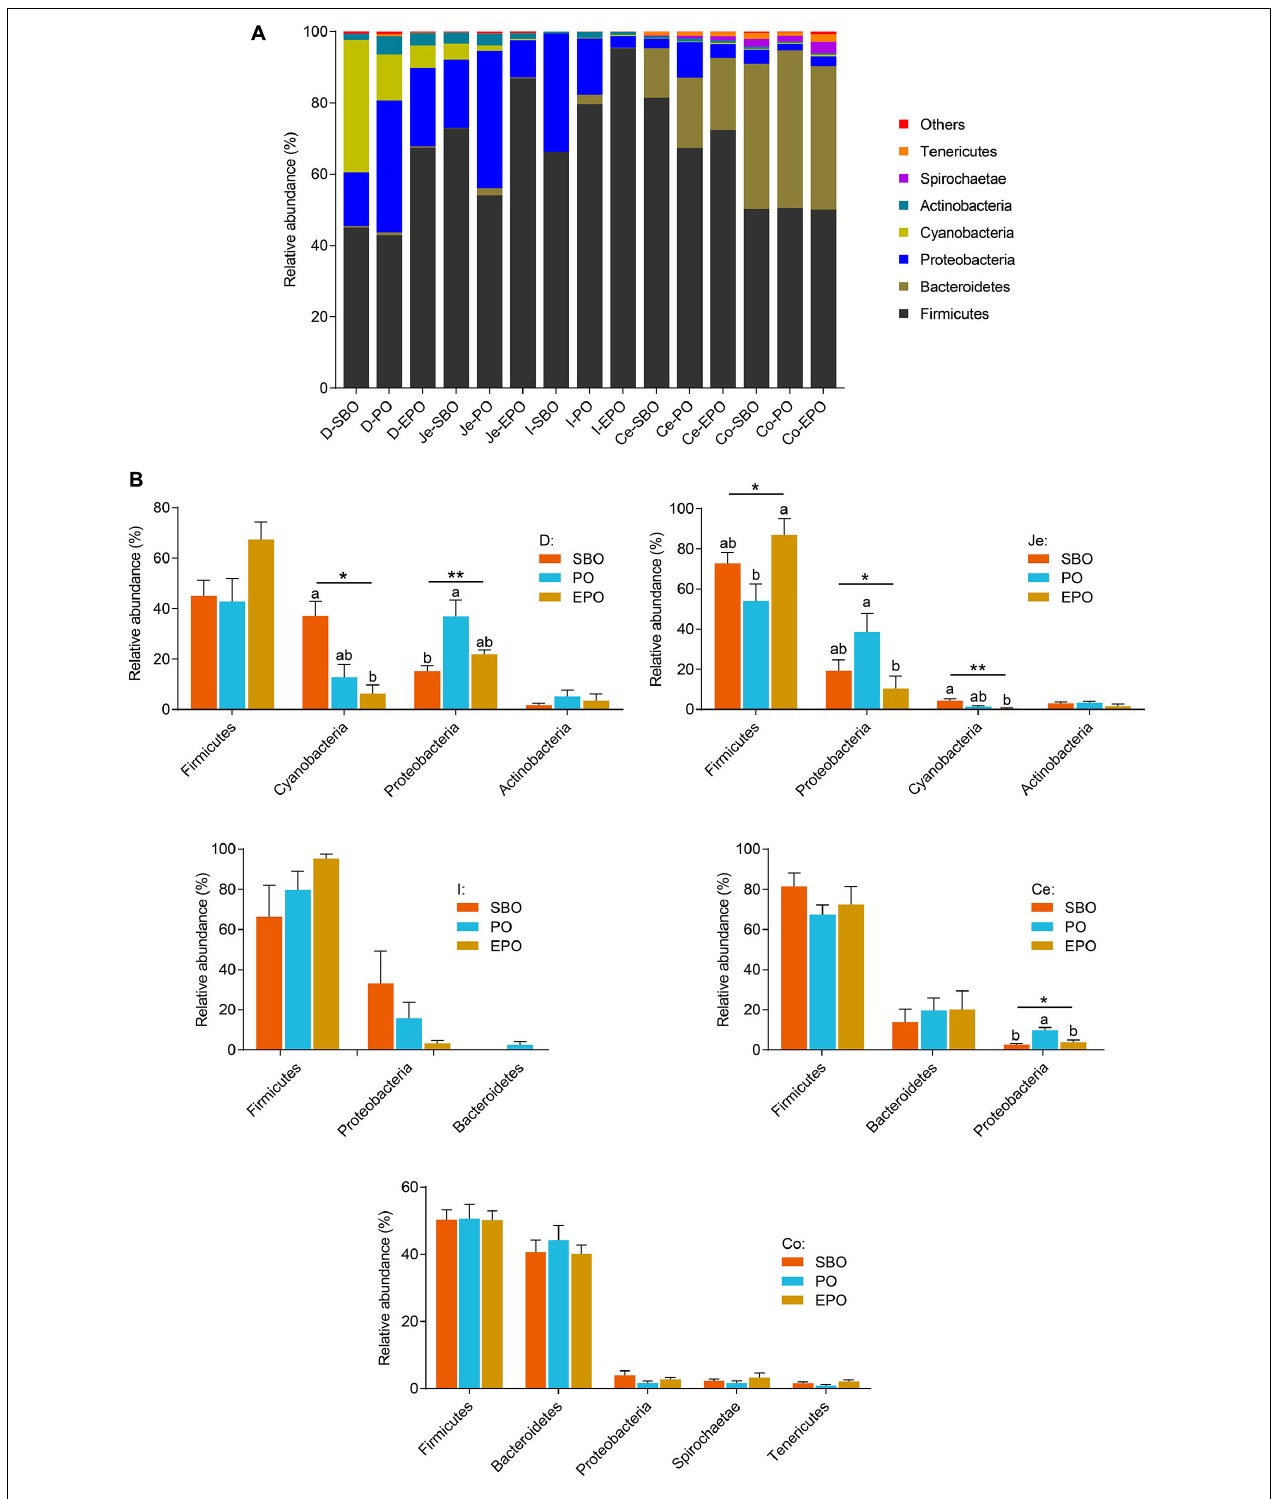
FIGURE 3 | Phylum-level composition. (A) The phylum -level taxonomic composition of average relative abundance of bacterial communities in the SBO, PO, and EPO groups. (B) The changed bacterial phyla found in each segment of the intestine of piglets (the mean abundance more than 2% at least one group, analyzed using Kruskal–Wallis sum-rank test). * P < 0.05; ** P < 0.01. D-, duodenum-; Je-, jejunum-; I-, ileum; Ce-, cecum-; Co-, colon; SBO, soybean oil; PO, palm oil; EPO, encapsulated palm